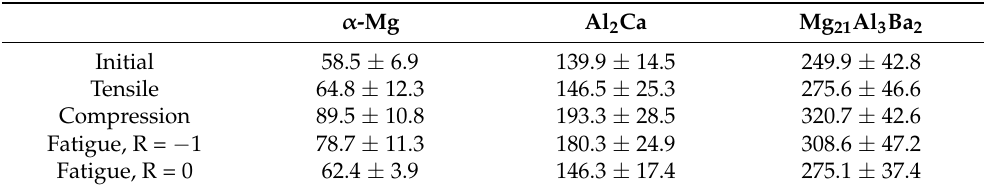
Table 1. Hardness (HV0.005, average values) of α -Mg, Al 2 Ca and Mg 21 Al 3 Ba2 of the initial microstructure before and after the different loading conditions.